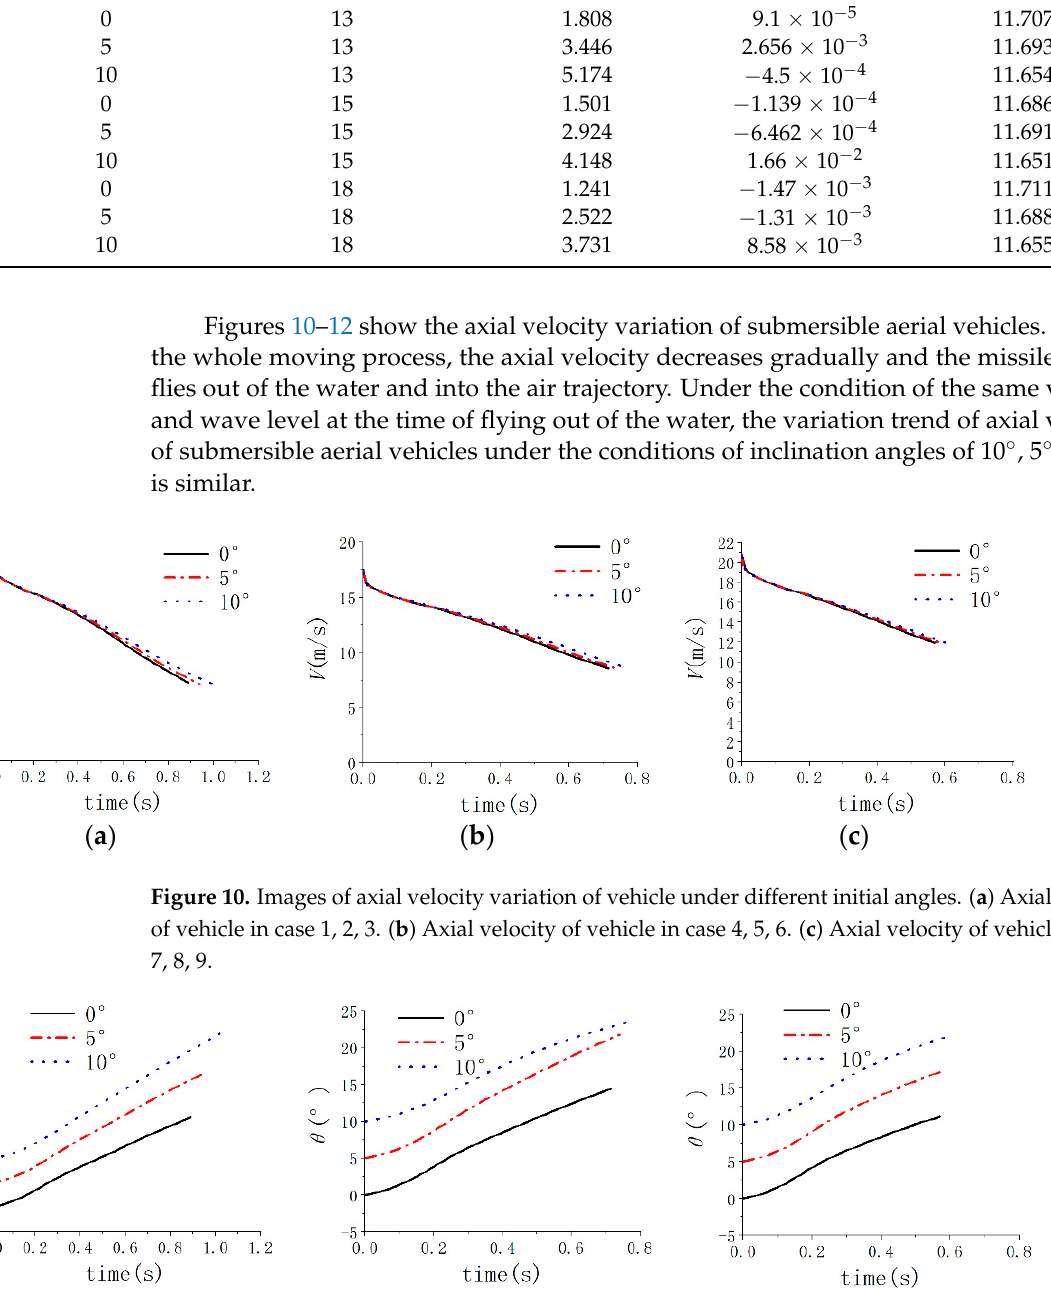
Figure 9. Centroid coordinates of vehicle in case 7, 8, 9. ( a ) Vehicle centroid X -axis coordinates. ( b ) Vehicle centroid Y -axis coordinates. ( c ) Vehicle centroid Z -axis coordinates.